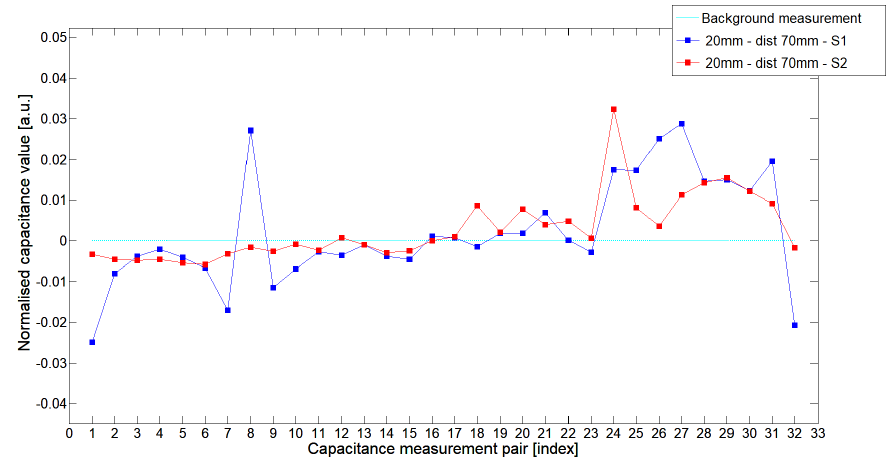
Figure 14. The 1st electrode measurement cycle (S1: 1->32 and S2: 1->32) for Test2 x 40 and S1—blue line, S2—red line. Cyan line indicates lower calibration limit.